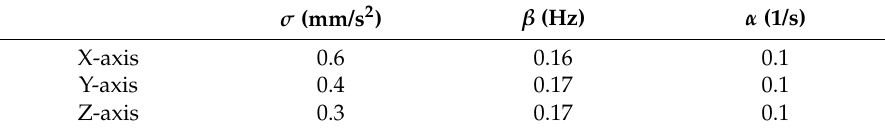
Table 4. Model parameters of acceleration measured by the accelerometers of